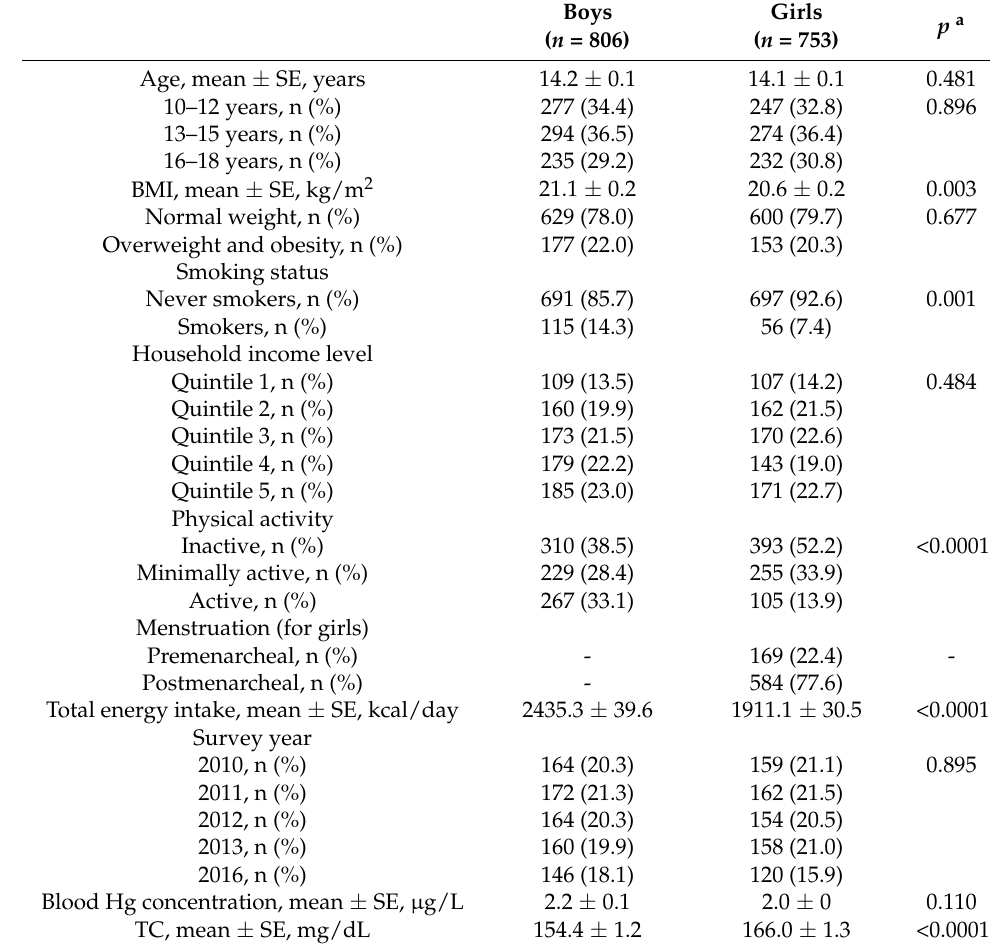
Table 3. Baseline characteristics of the study participants according to